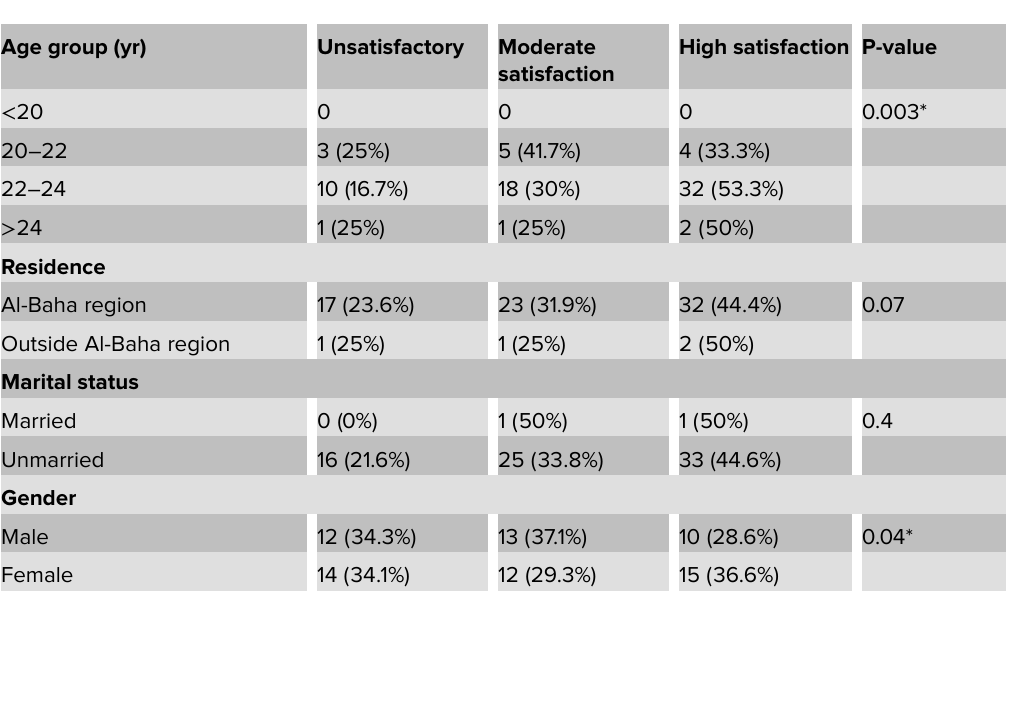
Table 3: Relationship between demographic characteristics of nursing students at Albaha University and their level of satisfaction, n =